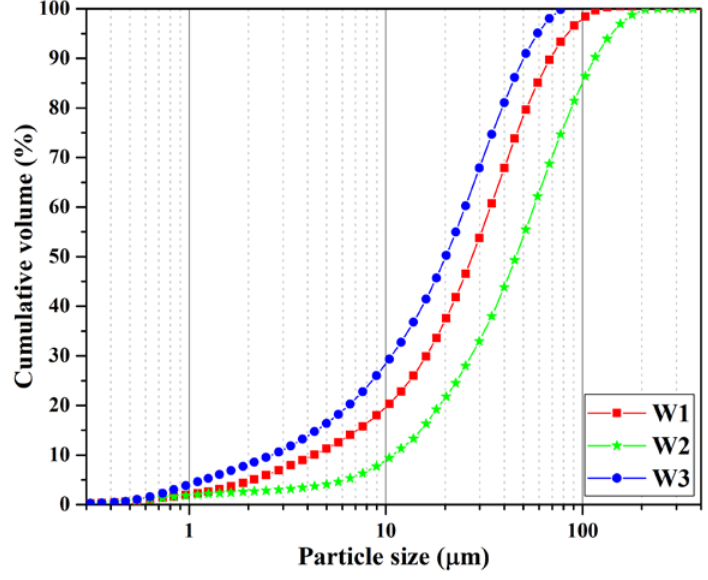
Figure 1. Distribution of particle size of WSA specimens.